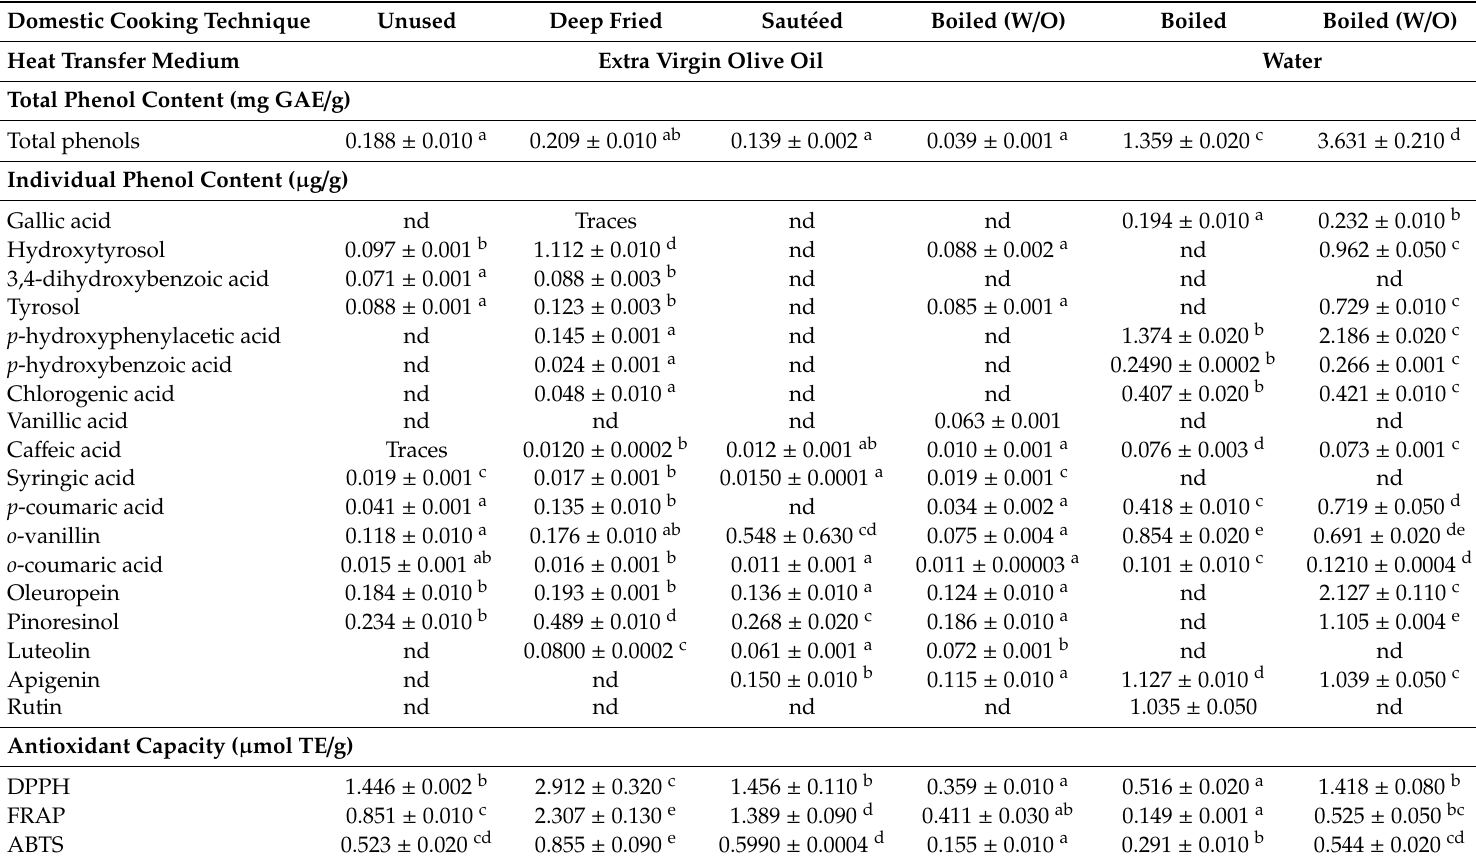
Table 3. Phenolic concentration and antioxidant capacity of EVOO and water used during the cooking of tomatoes according to four